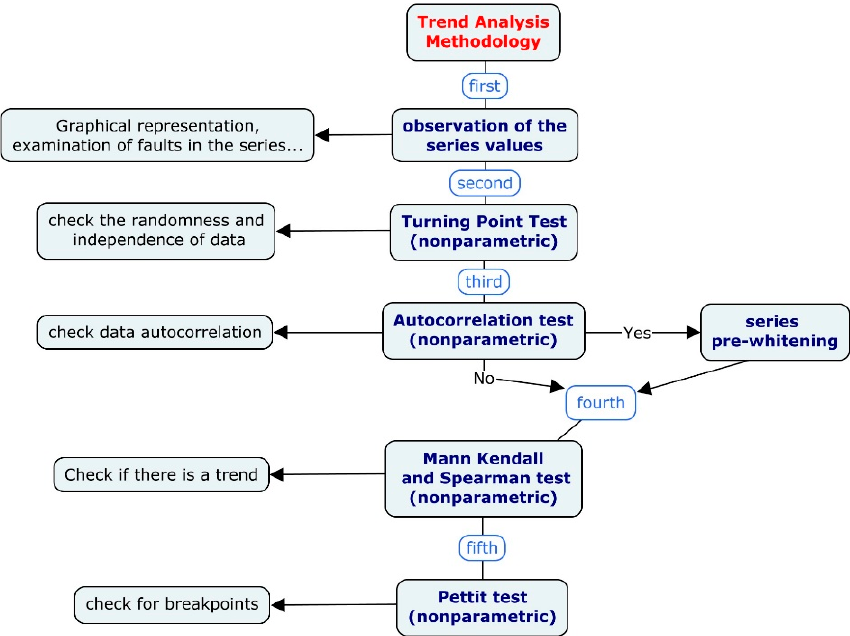
Figure 2. Conceptual map of the process followed for the analysis of trends of the di ff erent series considered.